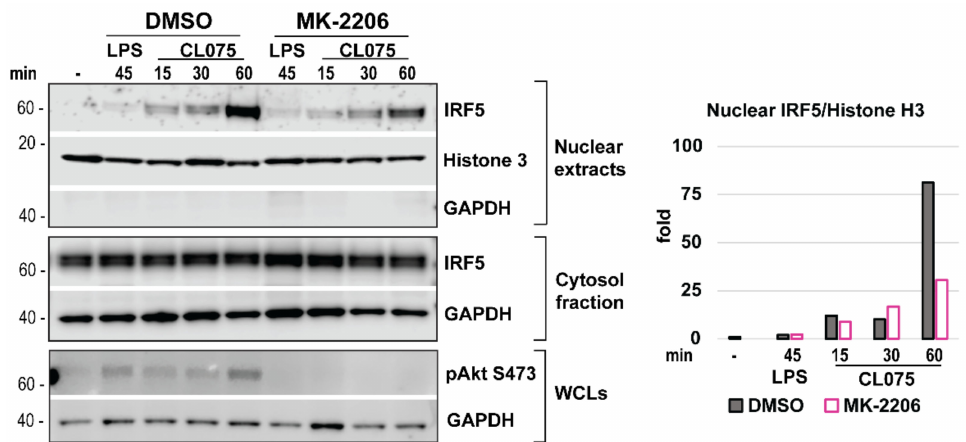
Figure 8. Inhibition of Akt reduced IRF5 nuclear translocation in human monocytes. Western blot analysis of cytosolic fraction and nuclear extracts from cells pre-treated with MK-2206 (2 µ M) was followed by stimulation with CL075 (2 µ g/mL) or LPS (100 ng/mL). LPS stimulation was applied for negative control. IRF5 levels in nuclear extracts were normalized based on Histone 3 bands’ intensity (graph), while GAPDH Western blot was performed to control for potential contamination of nuclear extracts with cytosol content. To control for Akt inhibition efficacy, Akt (S473) phosphorylation level was addressed in WCLs (whole cell lysates) from parallel wells. Representative of three consecutive experiments.